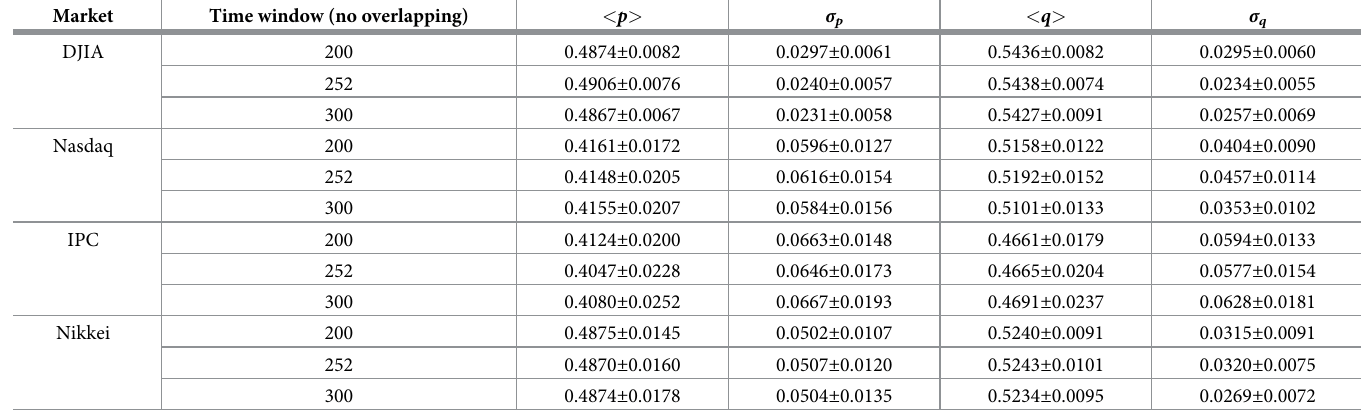
Table 9. Mean values and standard deviation of p and q distributions, generated this time by using no overlapping time windows, of of 200, 252 and 300 days. Obtained values are consistent with those shown in previous Table 8.